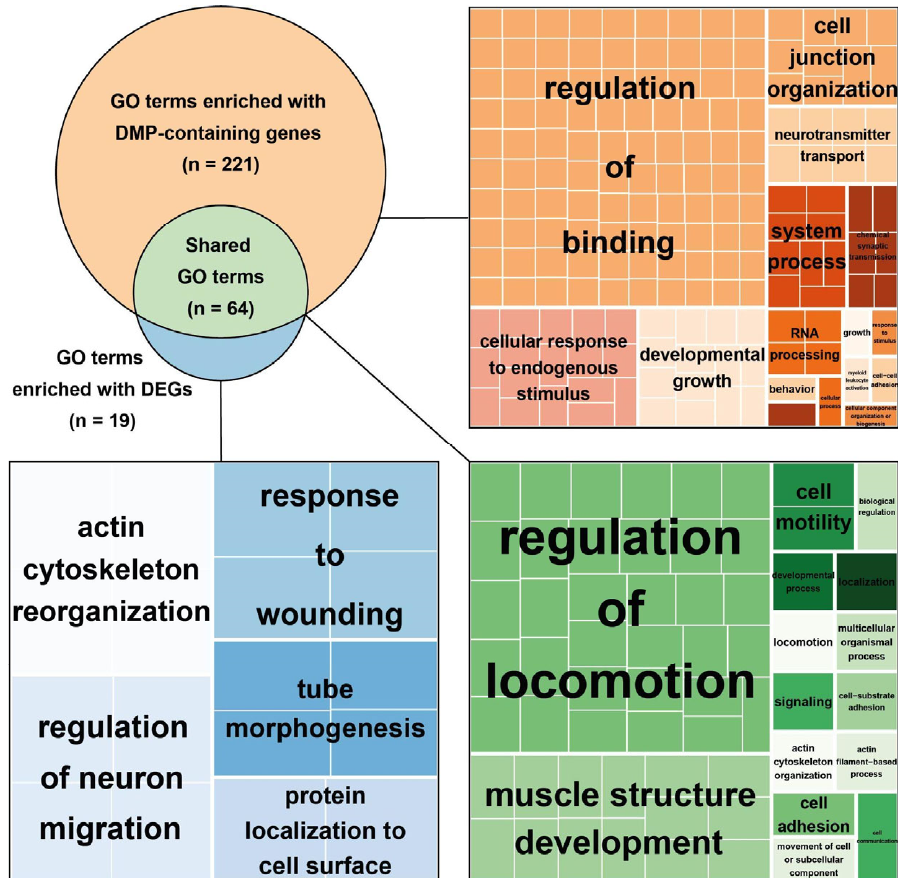
Figure 5. Visualization of GO terms overrepresented by DEGs and DMP-containing genes. Top left Euler-Venn diagram schematically represents sets of identified GO terms enriched with DMP-containing genes (orange) or with DEGs (blue) and their overlap (green). TreeMap diagrams show REVIGO clasterization of the identified GO term sets by similarity. Each colored rectangle on the map represents one GO term; the size of the rectangle indicates the ‘uniqueness’ of the GO term—the negative of its average similarity to all other input terms. Groups of similar processes forming the cluster are marked with the same color.